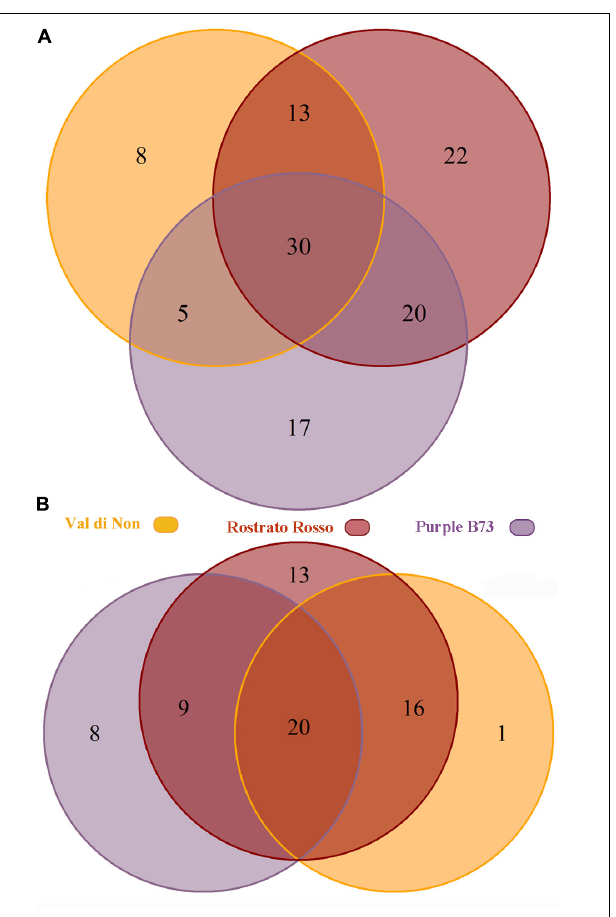
FIGURE 3 | Venn diagram of differentially accumulated compounds (Volcano plot analysis, P < 0.01, fold-change > 5), comparing each of the three genotypes against Agrister. The upper diagram (A) represents all the differential phenolic compounds, while the lower one (B) only the up-regulated